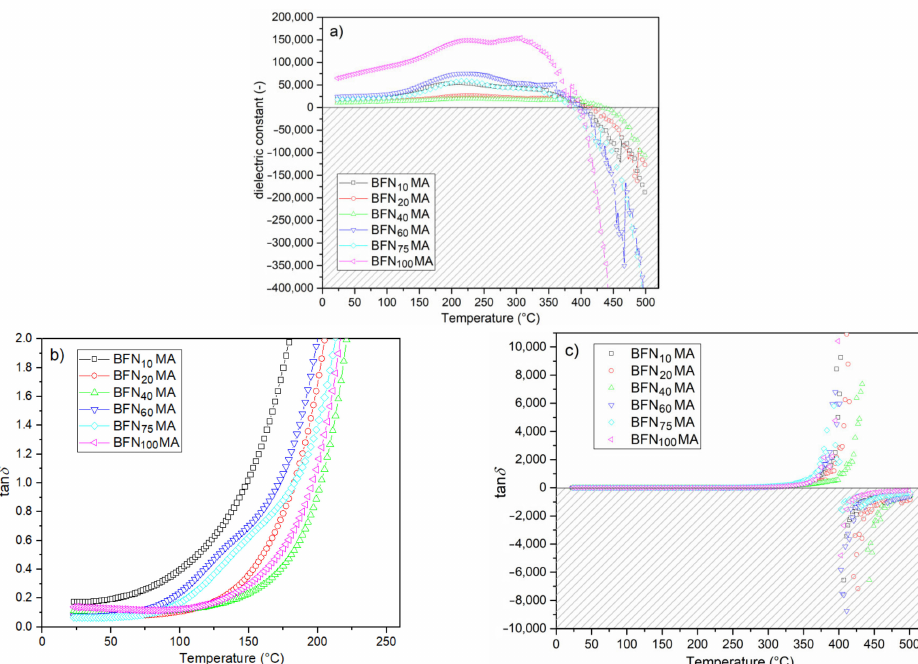
Figure 6. Temperature dependencies of dielectric properties for the BFN x MA ceramics (1 kHz): electric permittivity ( a ), dielectric loss (from RT to 250 ◦ C) ( b ), and dielectric loss (from RT to 500 ◦ C) ( c